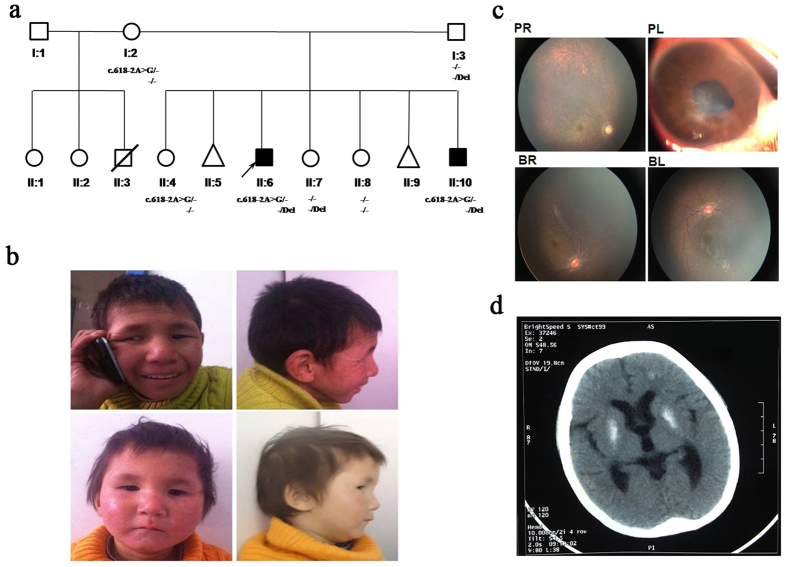
Pedigree and clinical characteristics of the two patients.(a) The family Pedigree. Black symbols denote affected individuals, and open symbols denote unaffected individuals. Genotypes are given for all family members who provided DNA. Del: the rearrangement removing exon 4 allele. -: the wild-type allele. (b) The facial features of the two patients. The top two photos show the proband (II:6); the bottom two photos show the affected sibling (II:10). (c) Fundus examination of the two patients. Figure PR and PL show optic nerve atrophy and retinitis pigmentosa in the right and left eye of the proband, respectively. Figure BR and BL show optic nerve atrophy in both eyes of the affected sibling. (d) The brain CT scan of the proband shows calcification of bilateral globus pallidus and subcortex of left frontal lobe, mild cerebral atrophy (widened sulcus and cleft, enlarged superatentorial ventricle) and cerebellar vermis dysplasia.